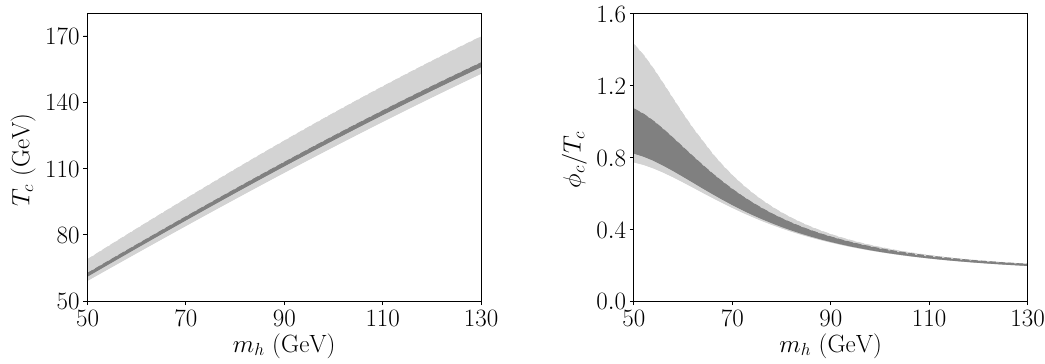
Figure 5 . Left: T c in a toy SM as a function of a light Higgs mass, in Landau gauge. Bands illustrate intrinsic uncertainty related to varying 4d RG scale in µ = (0 . 5 . . . 2 . 0) × πT , with two- (dark grey) and one-loop (light grey) thermal mass. Right: as left panel but for φ c /T c